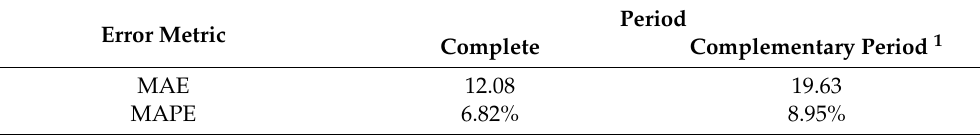
Figure 8. Regression results using the random forest algorithm on real data. ( a ) Regression results and actual data during the whole year and ( b ) regression results and actual data during the period complementary to the training phase. Table 6. Performance of the regression methods on the Real Data.